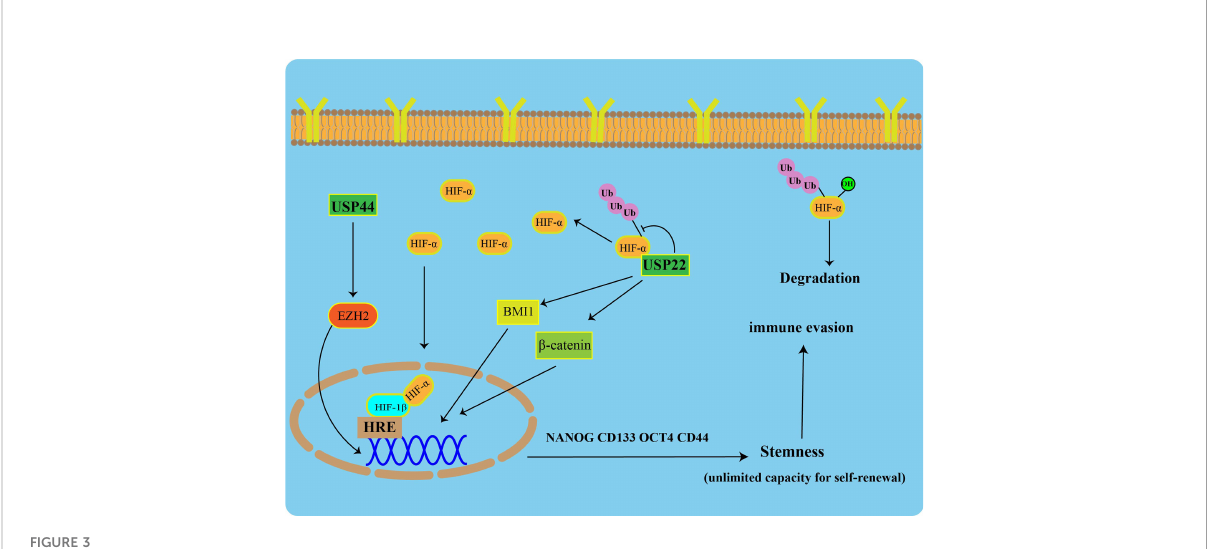
FIGURE 3 USPs-mediated tumor stemness and hypoxic microenvironment Under normoxic conditions, HIF-1 a is degraded via the ubiquitin-proteasome pathway. USP22 enhances the stability and transcriptional activity of HIF-1 a under hypoxia through deubiquitination and induces upregulation of HIF-1 a downstream genes. USP22 maintains cancer stemness by regulating BMI1 and b -catenin pathways. Furthermore, USP44 promotes prostate cancer stemness by deubiquitinating